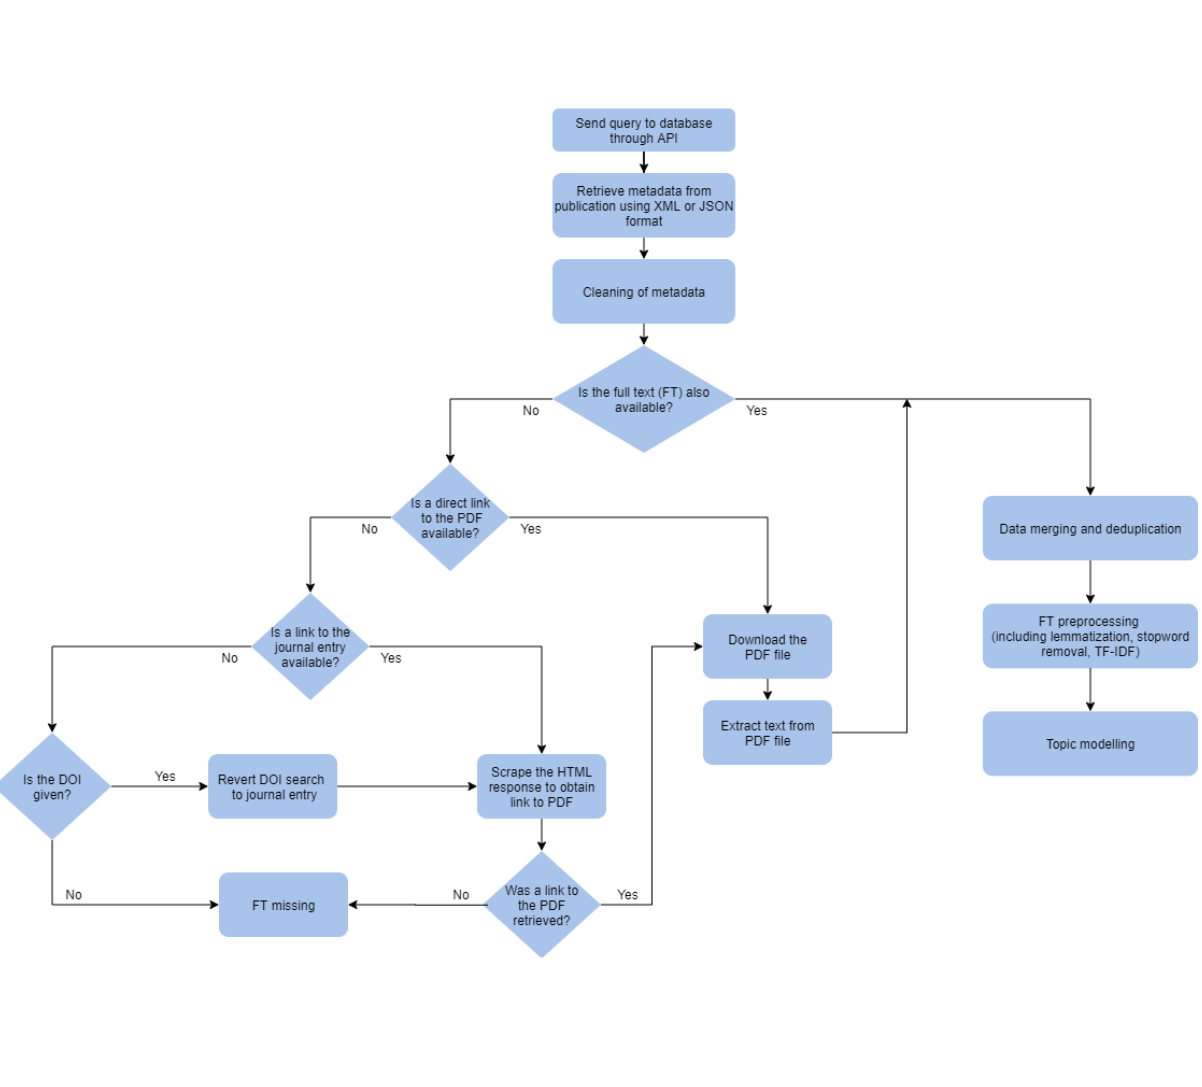
Figure 1. Flow for gathering and preprocessing data. API: application programming interface; DOI: Digital Object Identifier; TF-IDF: term frequency-inverse document